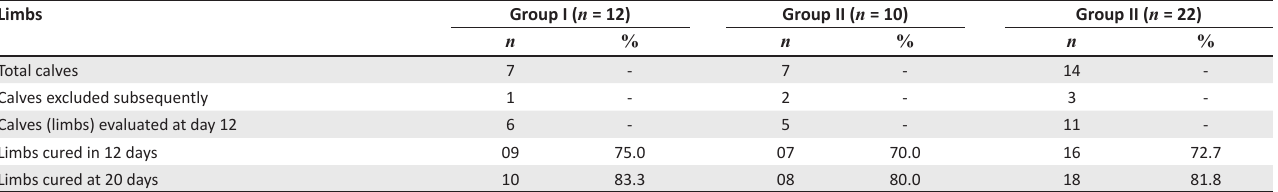
Limbs cured in 12 days